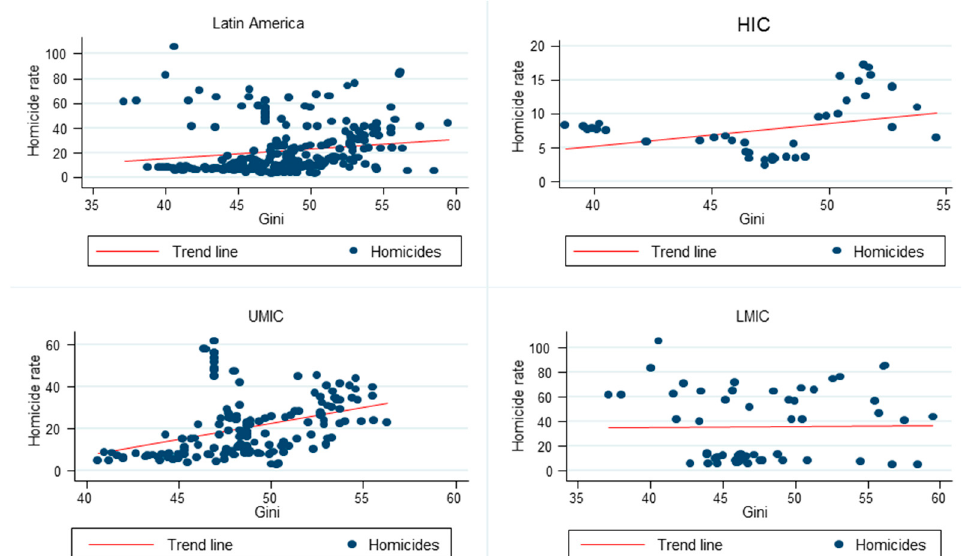
Figure 1. Relationship between homicide rate and income inequality. Source: Own elaboration with data from the World Bank [44] and WHO [45].